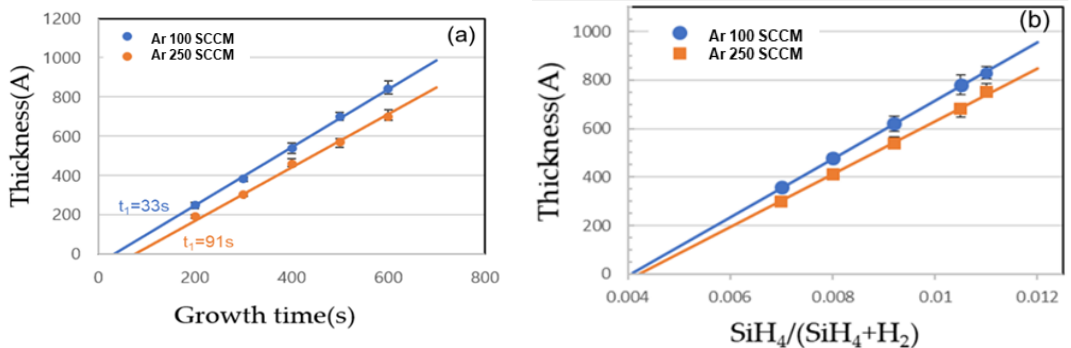
Figure 4. The thickness and the linear plot of the polycrystalline Si grown at 520 °C on 100-nm-thick SiO 2 with ( a ) growth time (SiH 4 flow rate of 7 SCCM) and ( b ) SiH 4 flow ratio (growth time of 300 s).